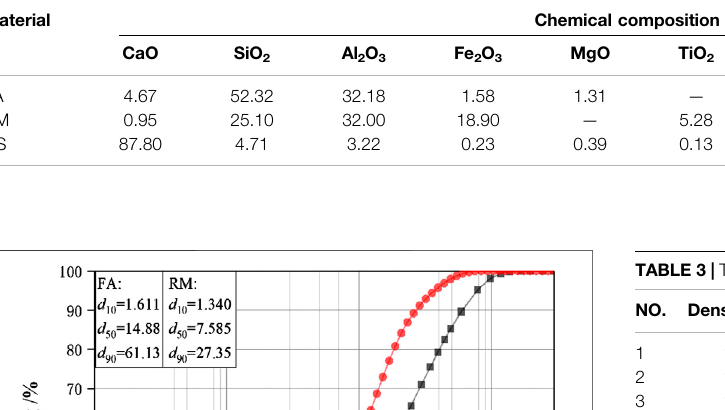
TABLE 1 | Chemical composition of fl y ash, red mud and carbide slag w/%.